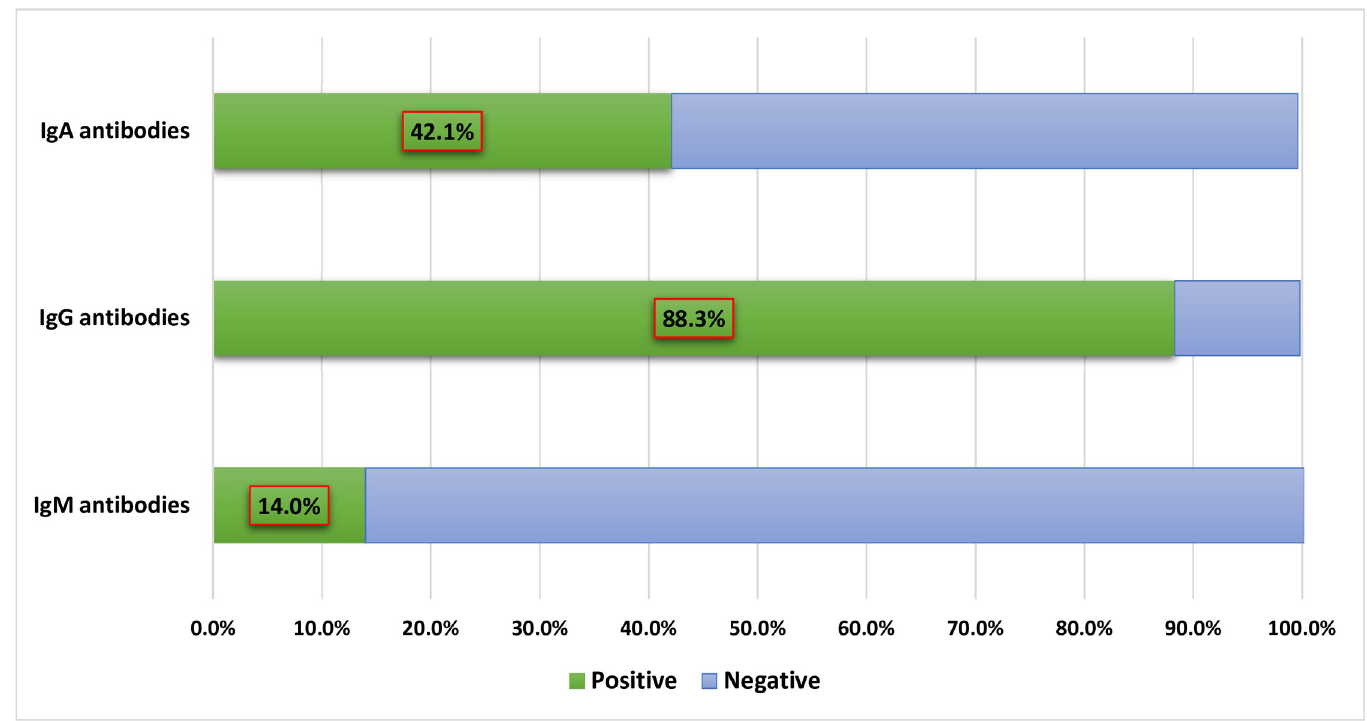
Fig 2. The prevalence of IgM, IgG, and IgA-specific antibodies in a random sample of SARS-CoV-2 samples (n = 171).